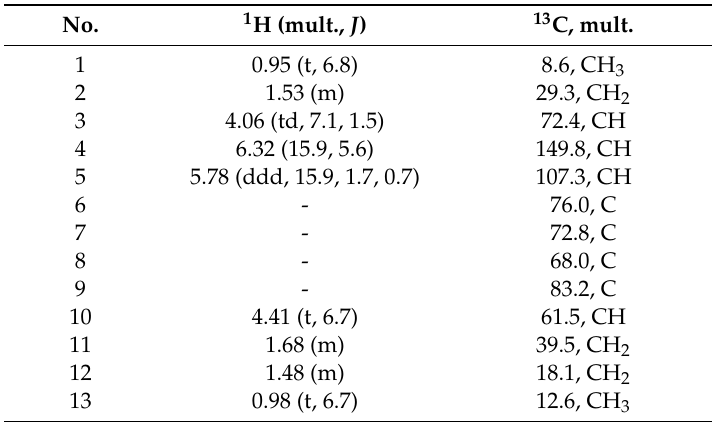
Table 2. NMR data assignment of